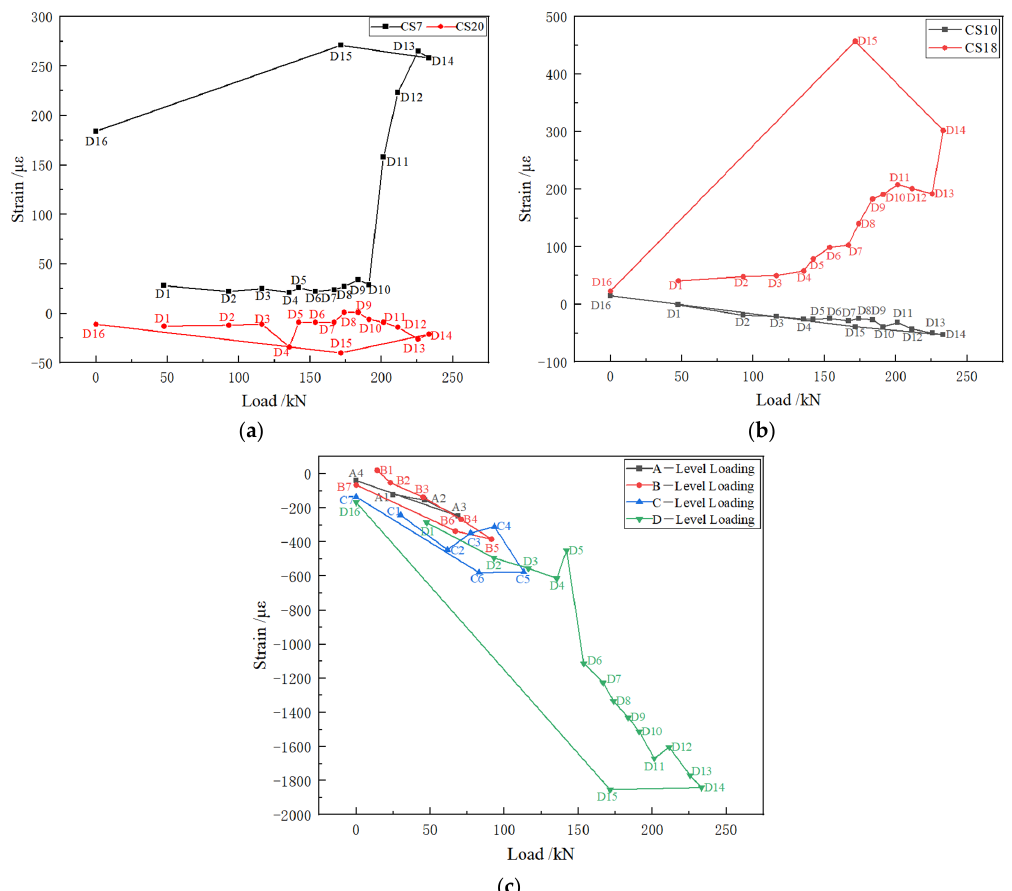
Figure 14. Arch strain curve. ( a ) CS7 and CS20 strains; ( b ) CS10 and CS18 strains; ( c ) CS15 strain.